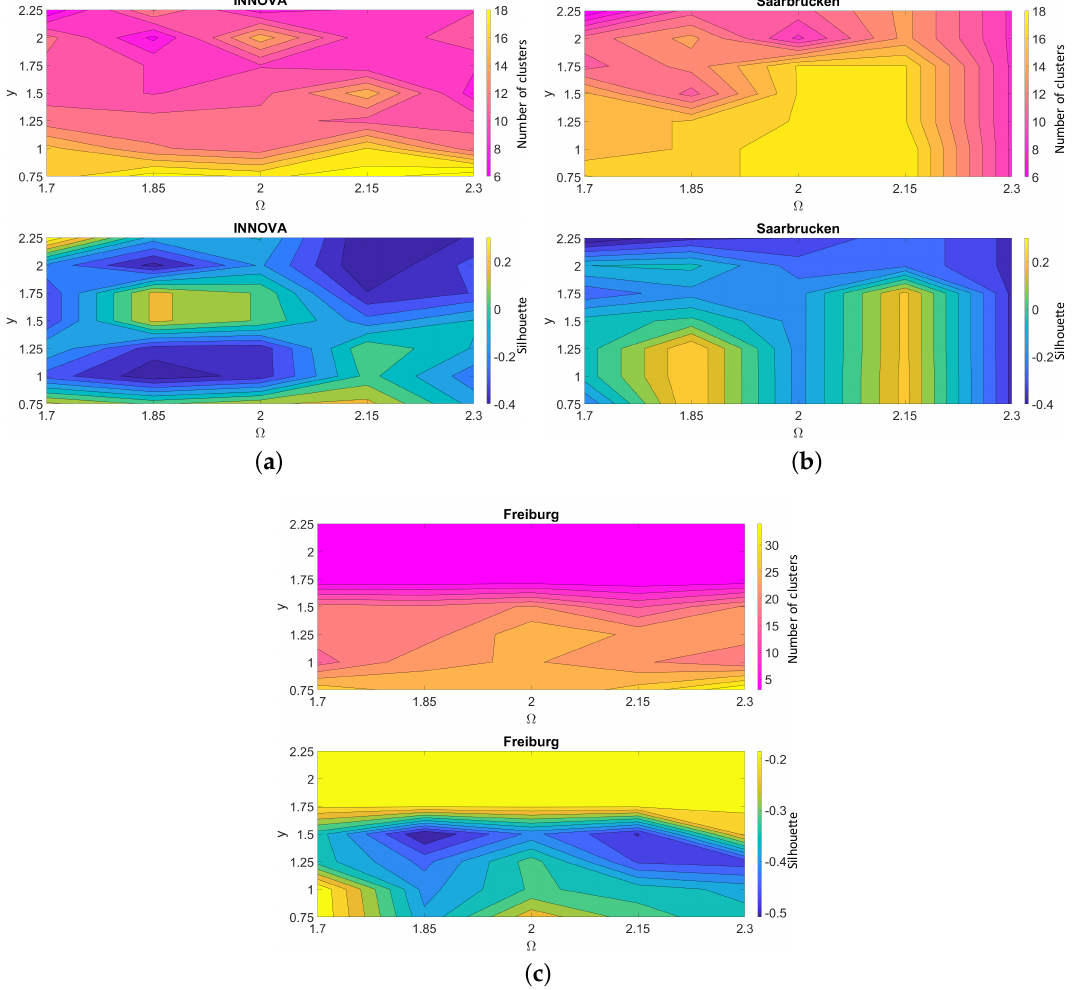
Figure 9. Results obtained with the HOG descriptor for different values of y and Ω for the datasets ( a ) INNOVA, ( b ) Saarbrücken and ( c ) Freiburg. The first row of each subfigure shows the final number of clusters (colour mapped) and the second one the average silhouette (colour mapped) after the proposed incremental hierarchical mapping